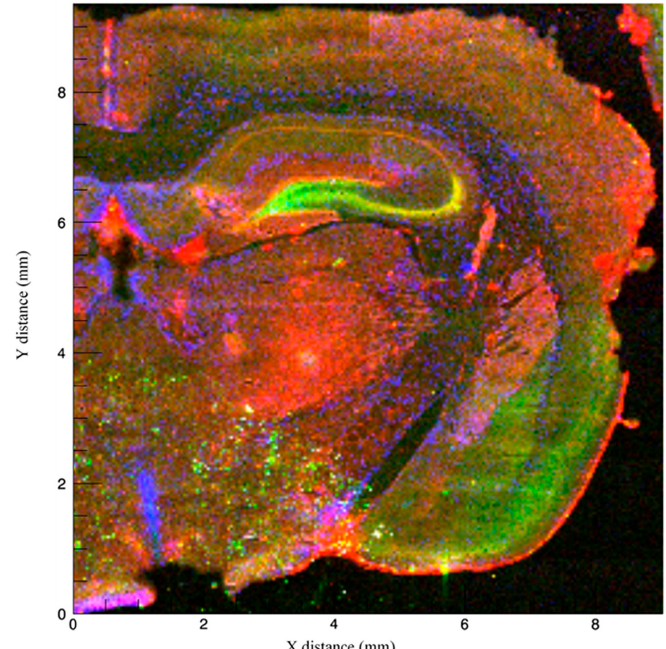
Figure 2. Coronal section of a 4-month-old Sprague–Dawley rat imaged using Synchrotron X-ray fluorescence, with fluorescence intensity of Zn (green), Cu (blue), and Fe (red) normalized to the incident X-ray intensity.